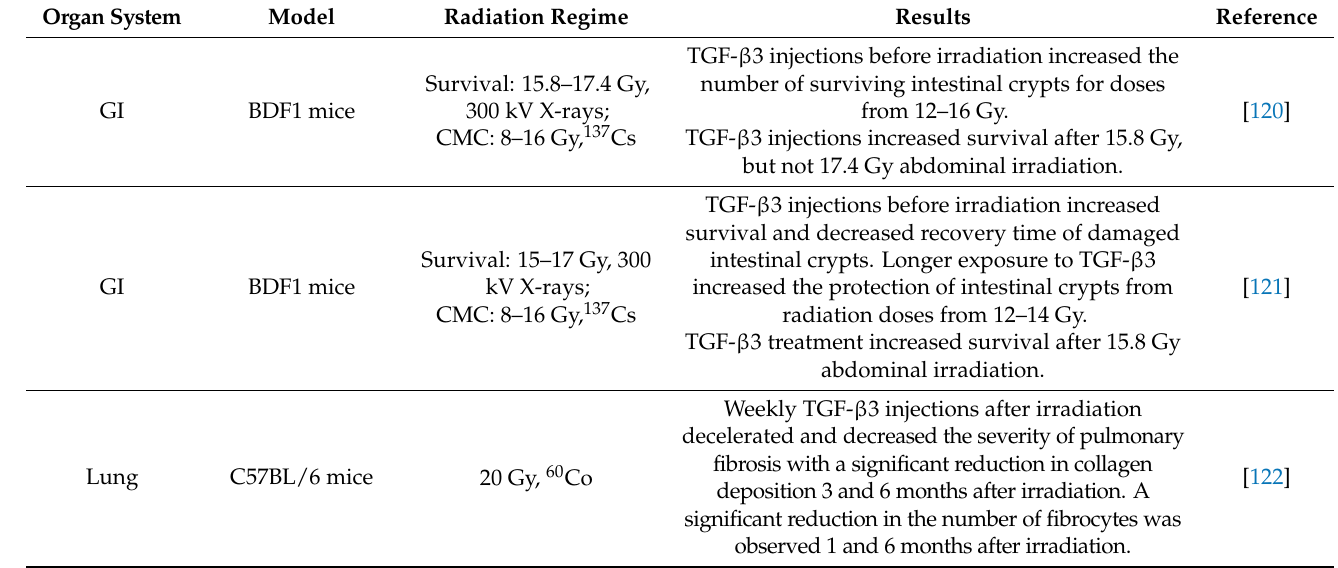
Table 4. Preclinical studies of treatment with exogenous TGF- β 3 in combination with irradiation. CMC: Crypt microcolony